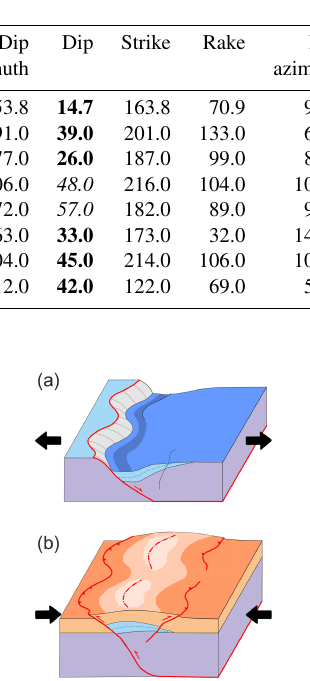
Table 1. Nodal planes from the International Seismological Centre (2015) database for reviewed events only. In addition to the dip, the dip azimuth of the planes is calculated. The strike and rake values from the database are given for completeness and assessment of obliquity. Event F1 has three different solutions in the database. The differences are a rough indication of the uncertainty in the data. Bold and italic dip values indicate the lower and higher dip surfaces of the pair. The author column refers to the original provider in the database (see Lentas et al., 2018, and references therein).